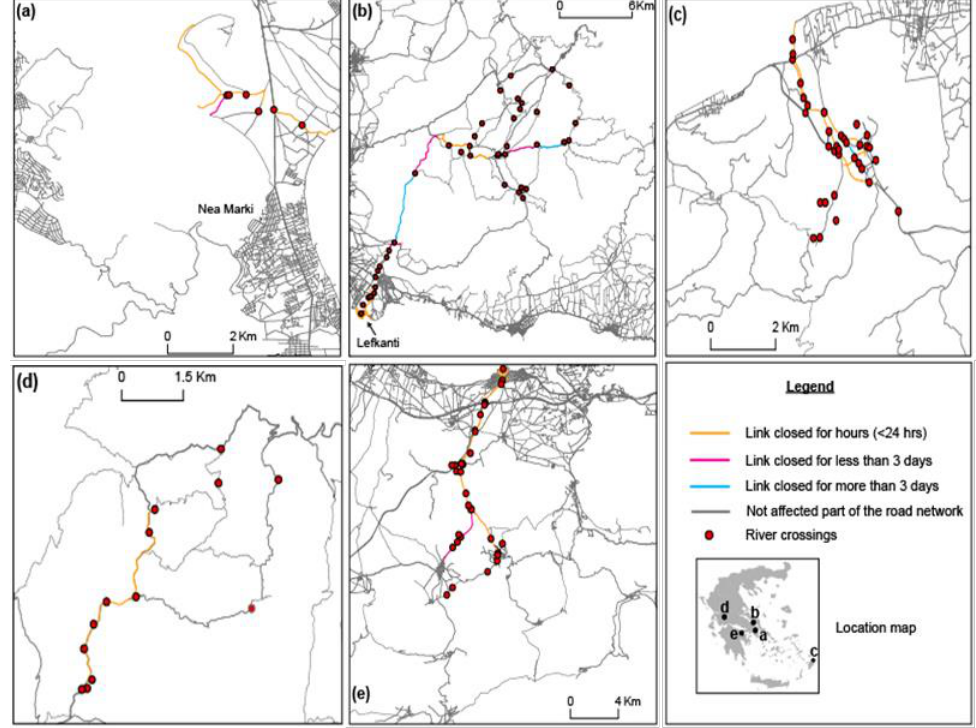
Figure 9. Closed road network after the extreme precipitation events per examined basin